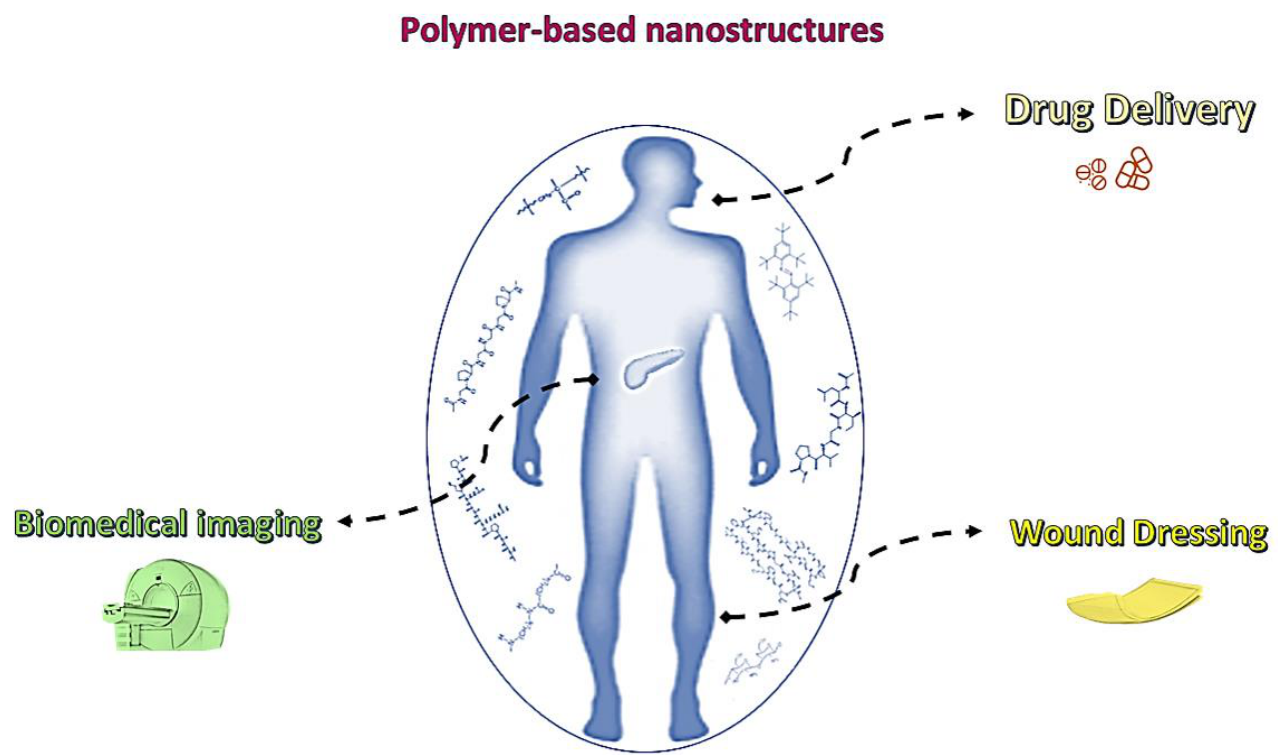
Figure 2. Overview of ways polymer-based nanostructures can benefit diabetes management. A variety of polymer-based nanostructures can be used to manage diabetes, including fluorescence and magnetic resonance imaging to detect β-cells; drug delivery via oral, buccal, nasal, pulmonary, and transdermal routes; wound healing.